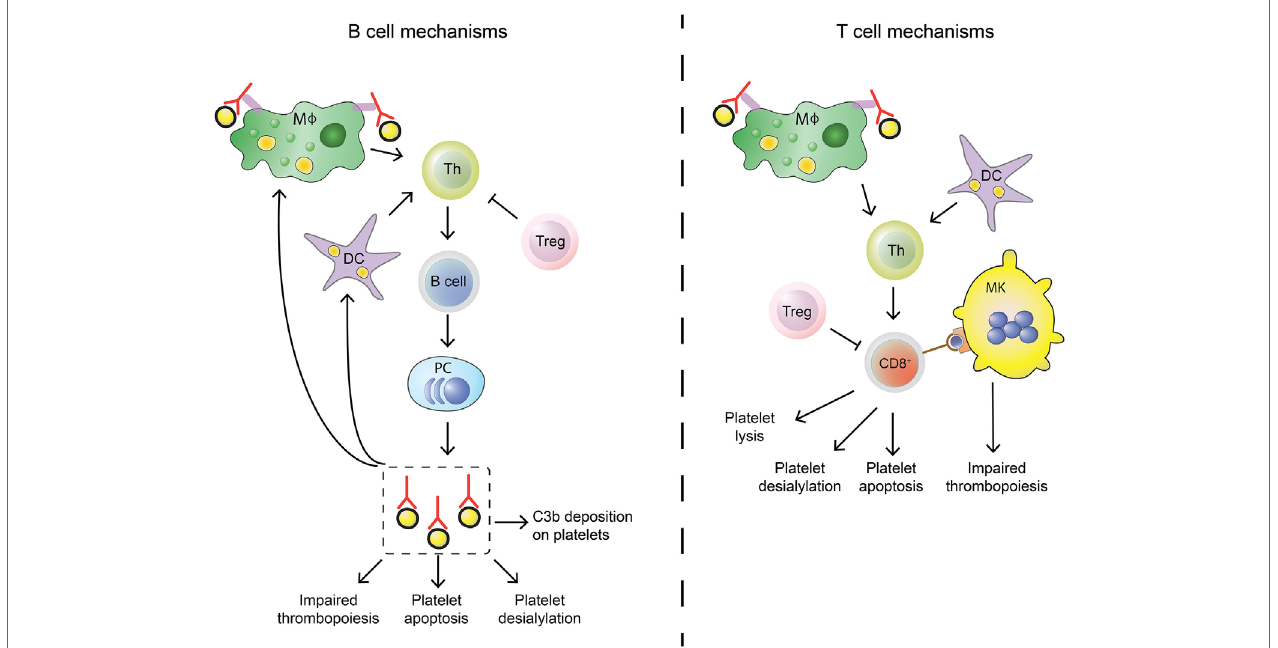
FiGURe 2 | Differences in B cell and T cell mechanisms in immune thrombocytopenia (ITP). B cells (left) differ from cytotoxic T cells (Tc) (right) in their autoimmune response against platelets in ITP. Stimulation of the adaptive immune response is similar: splenic macrophages (green) and dendritic cells (DCs, purple) can phagocytose platelet fragments to present to T helper (Th, light green) cells. Th cells are able to induce B cell development into autoantibody secreting plasma cells and can also stimulate cytotoxic Tc effector mechanisms. This process is regulated by regulatory Tc (Treg, pink), but regulatory T cell levels are imbalanced in ITP patients which leads to insufficient control of the autoimmune response. Shared effector functions of B cell-produced autoantibodies and cytotoxic Tc include impairing thrombopoiesis by targeting megakaryocytes (MKs), inducing platelet apoptosis and enhancing platelet desialylation. Autoantibodies can further stimulate C3b deposition on platelets to initiate complement activation, while cytotoxic Tc can directly lyse